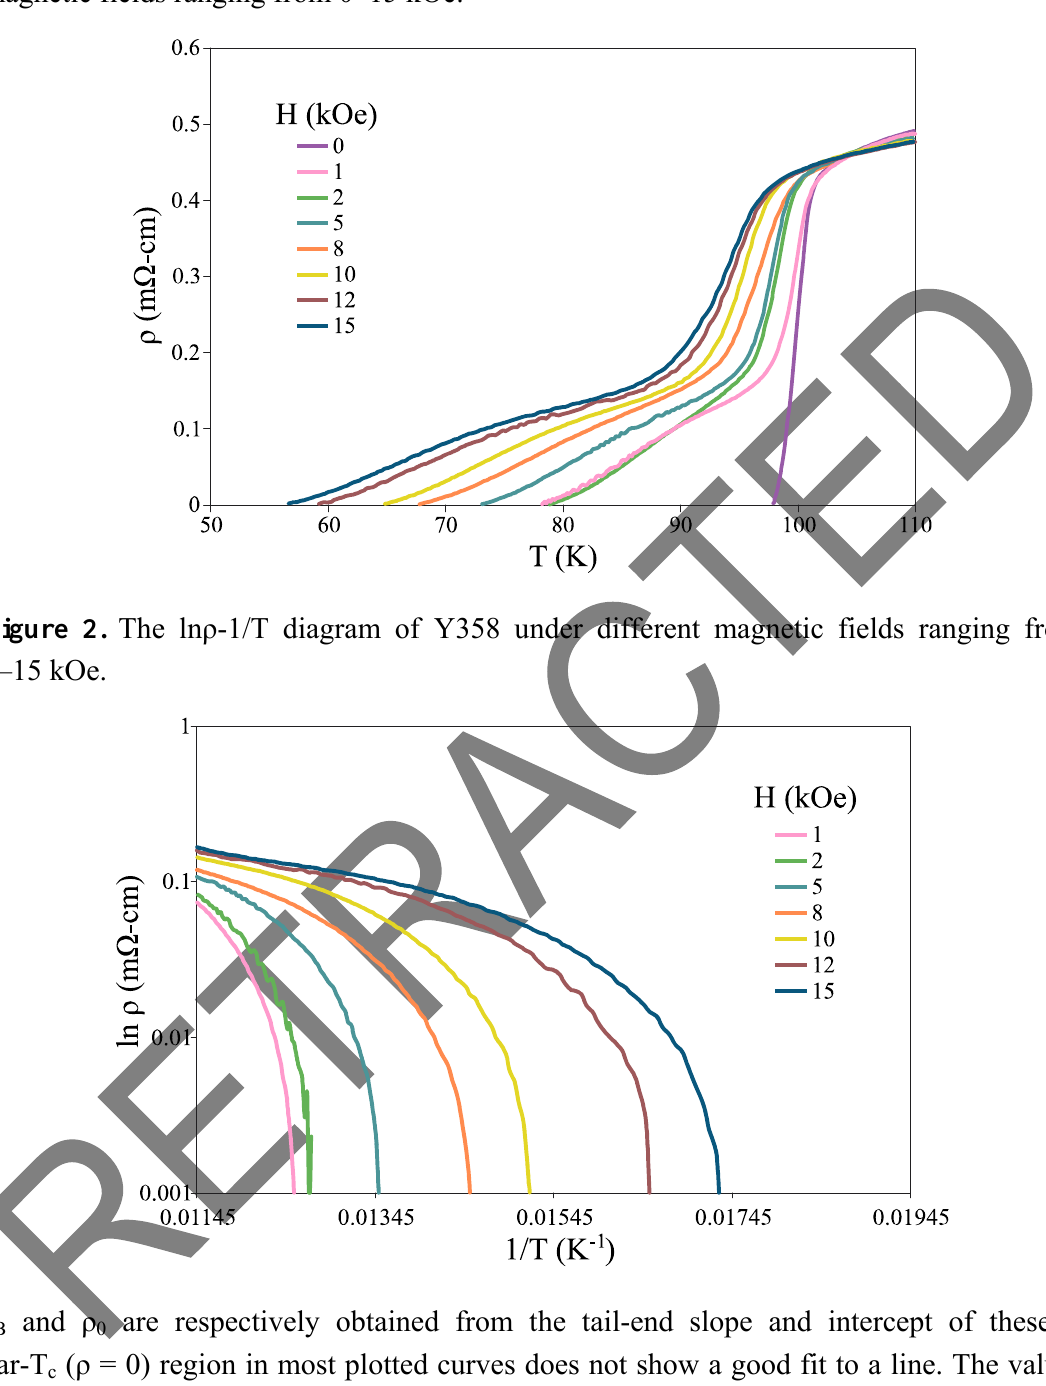
Figure 1. Specific electric resistance of Y358 with respect to temperature under different magnetic fields ranging from 0–15 kOe.